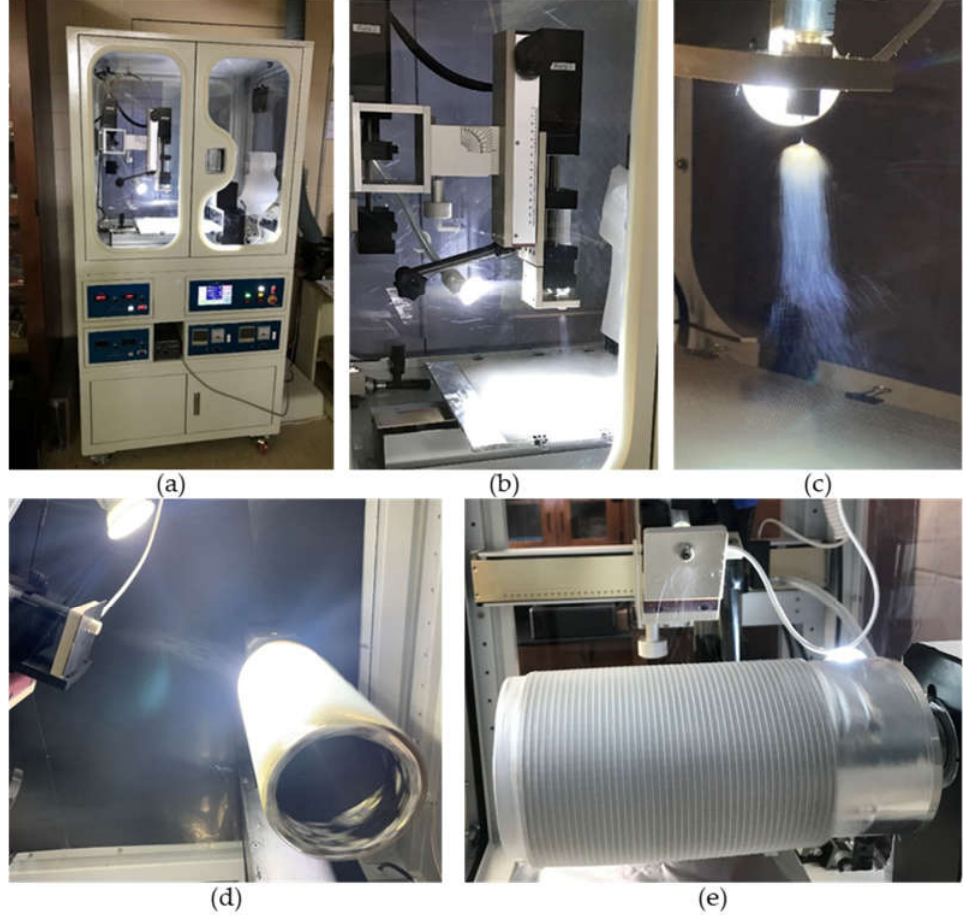
Figure 3. Electrospinning configurations. ( a ) NanoNC model ESR200R2D electrospinner. ( b ) Vertical alignment onto flat plate. ( c ) Spray pattern for vertical deposition. ( d ) Side view of horizontal alignment onto cylindrical roller. ( e ) Rear view of roller deposition.